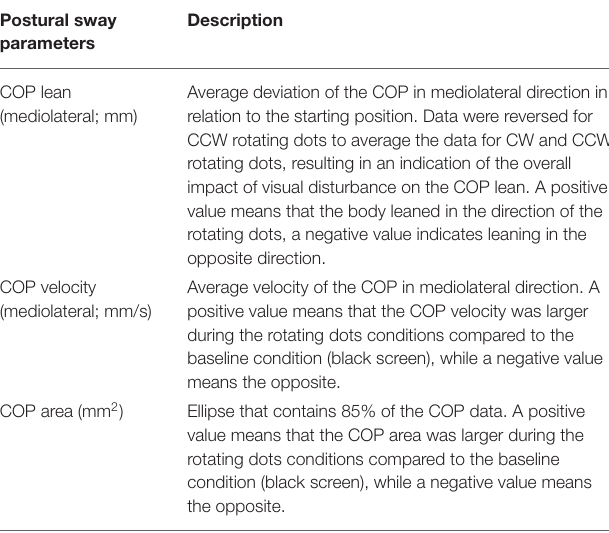
TABLE 1 | Parameters of the postural sway while facing rotating dots a . Postural sway